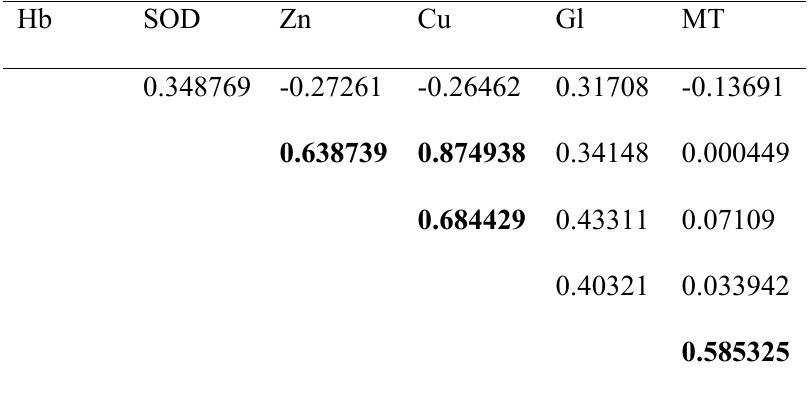
C ORRELATION PARAMETERS BETWEEN CALVES ’ BLOOD COMPONENTS